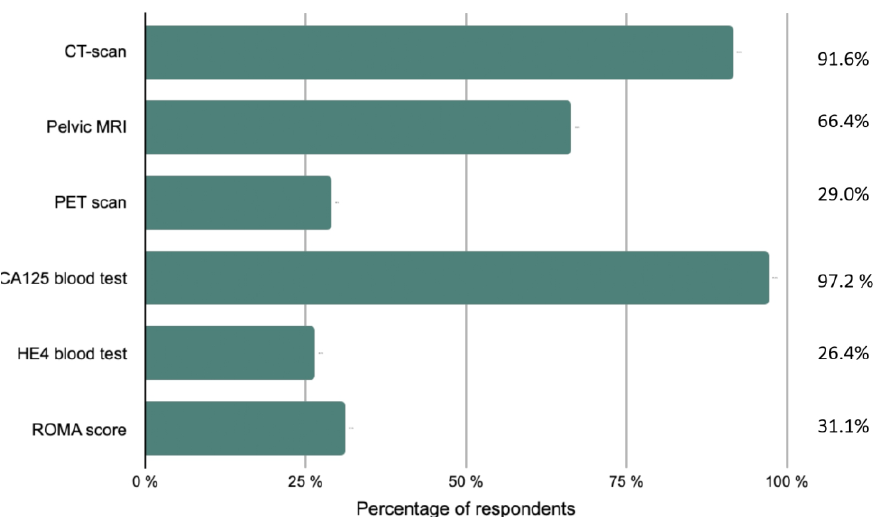
Figure 1. Initial diagnostic workup and staging performed by the